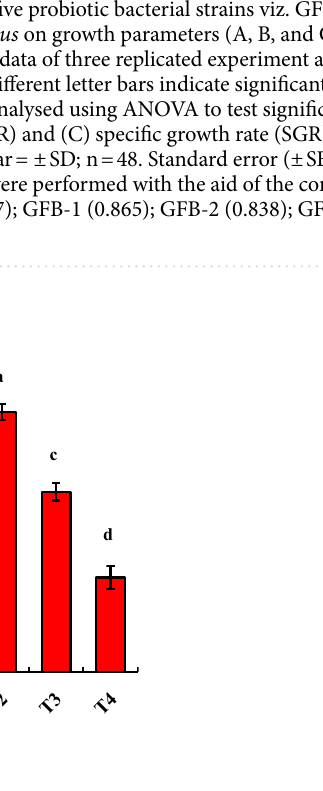
Figure 4. Comparative study between assessment of individual effects of five probiotic bacterial strains viz. GFB-1, GFB-2, GFB-3, GFB-4 and GFB-5 and consortium effects of five bacterial strains viz T2, T3 and T4 isolated from the gut of B. gonionotus on weight gain of the host fish. One way ANOVA was performed for analyzing the data of three replicated experiment and data in column varies significantly in LSD at P < 0.05 (Statistix 10). Different letter bars indicate significant variations in weight gain of fish in different groups by the isolates at P < 0.05 (Statistix 10). Error bar = ± SD; n =